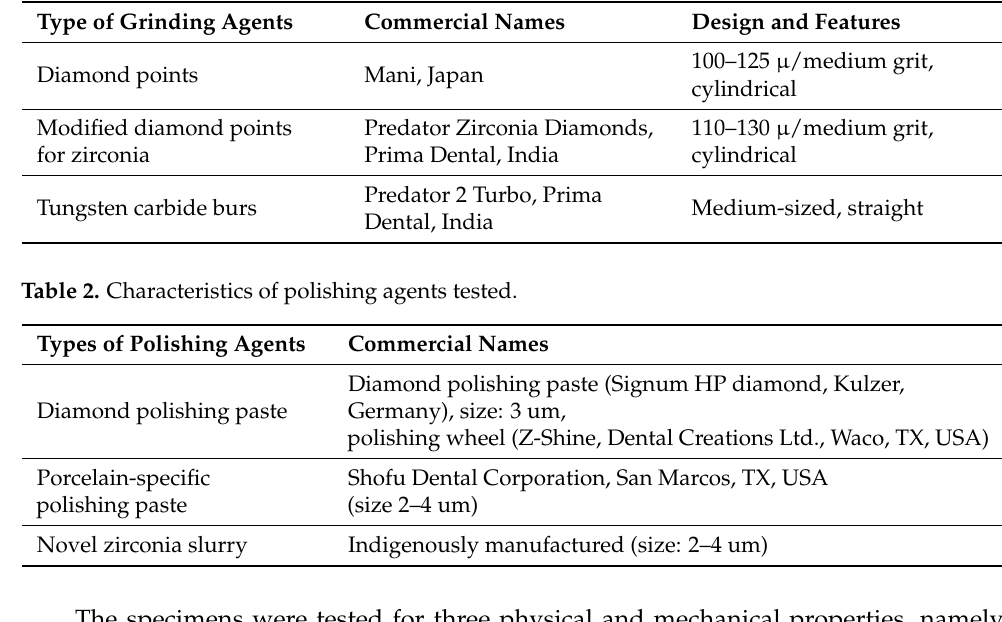
Table 1. Characteristics of grinding agents tested.